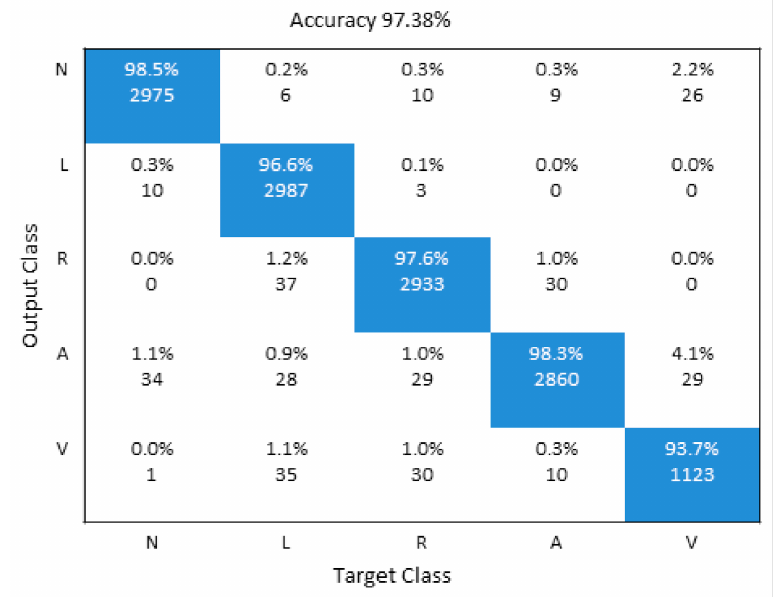
Figure 6. Illustration of confusion Matrix of 1D CNN